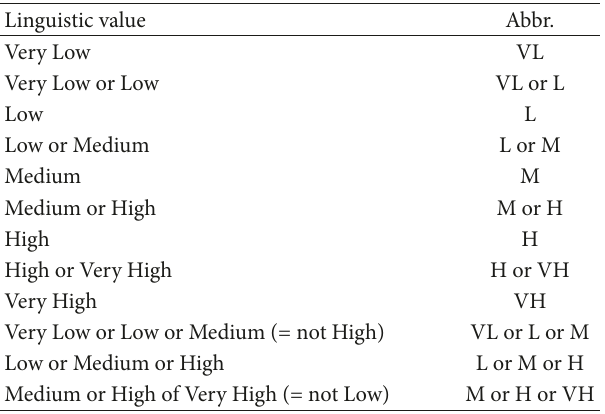
Table 2: 12 linguistic values for fuzzy reasoning. Linguistic